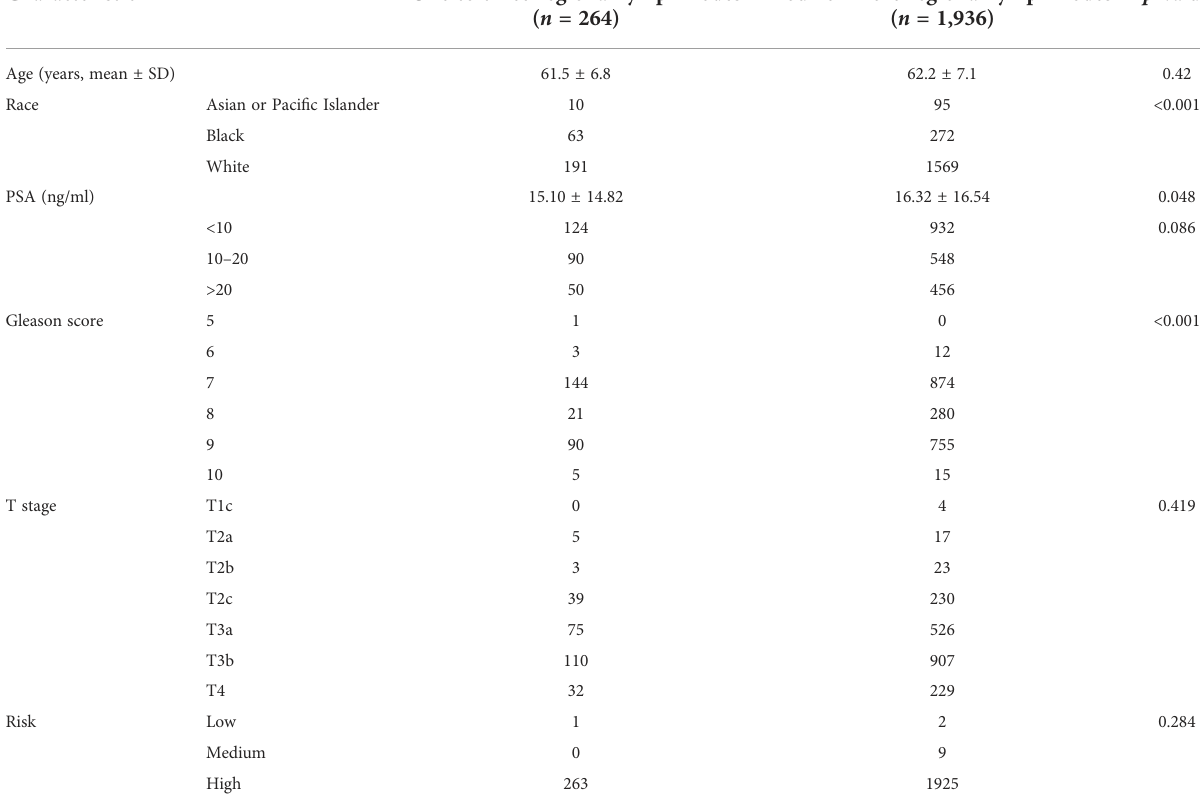
TABLE 1 Characteristics of included